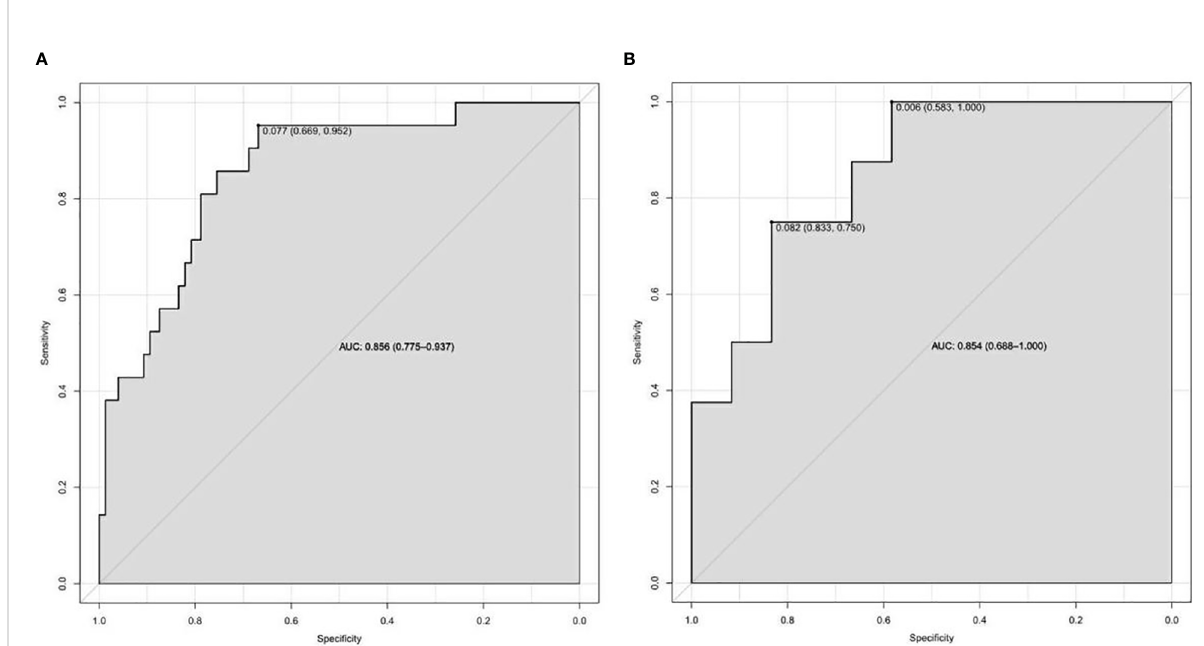
FIGURE 3 The discrimination performance of the nomogram was excellent in both the training (A) and validation (B)